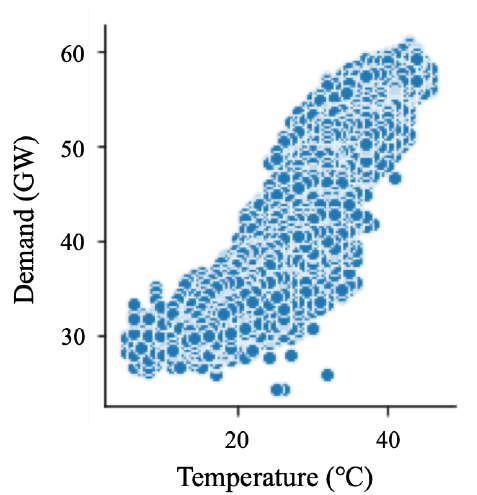
Figure A1. KSA electricity demand and Riyadh city temperature data for